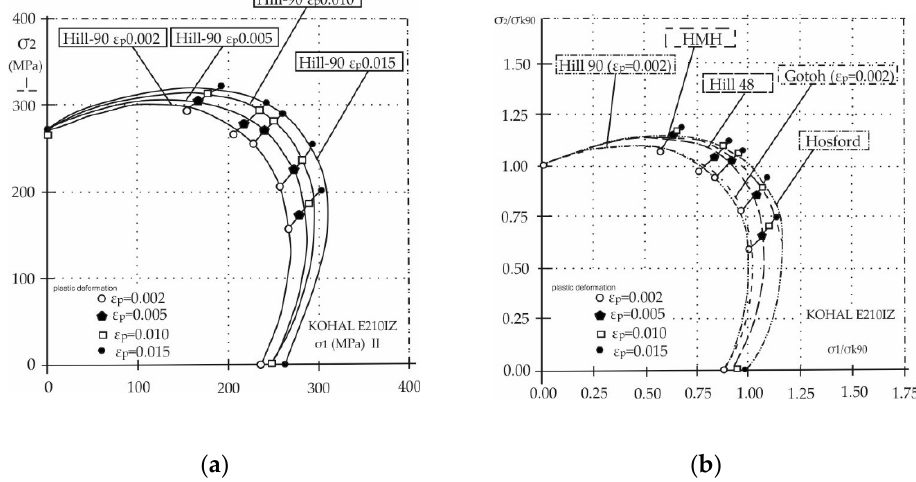
Figure 39 . ( a ) Experimentally determined points of plasticity curves of KOHAL E 210 IZ in stress σ 1 and σ 2 , on ( b ) experimentally determined points of plasticity curves shown in stress σ 1 / σ k 90 and σ 2 / σ k 90